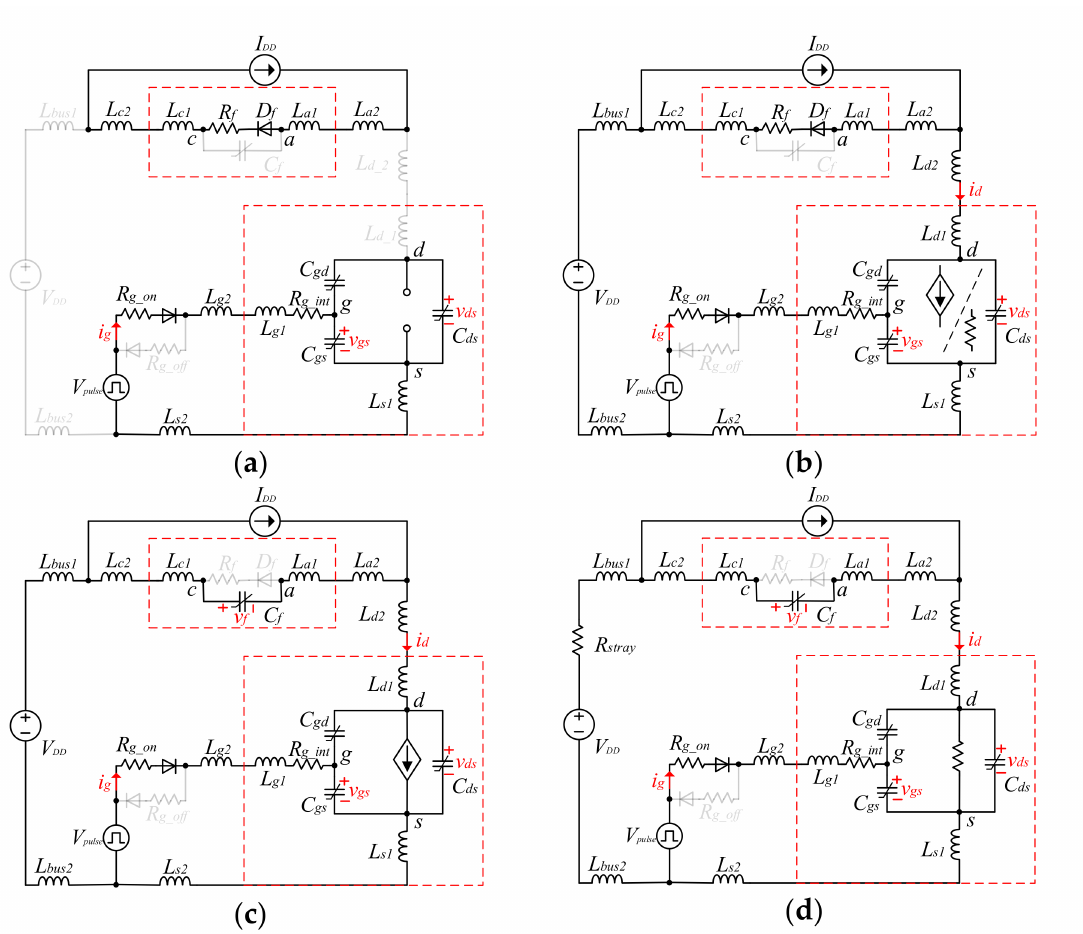
Figure 4. Equivalent circuits for the turn-on transients. ( a ) Stage 1. ( b ) Stage 2. ( c ) Stage 3. ( d ) Stage 4 and Stage